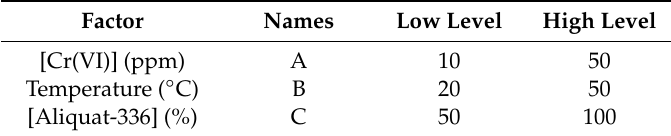
Table 2. Feed phase factors and fields of study.